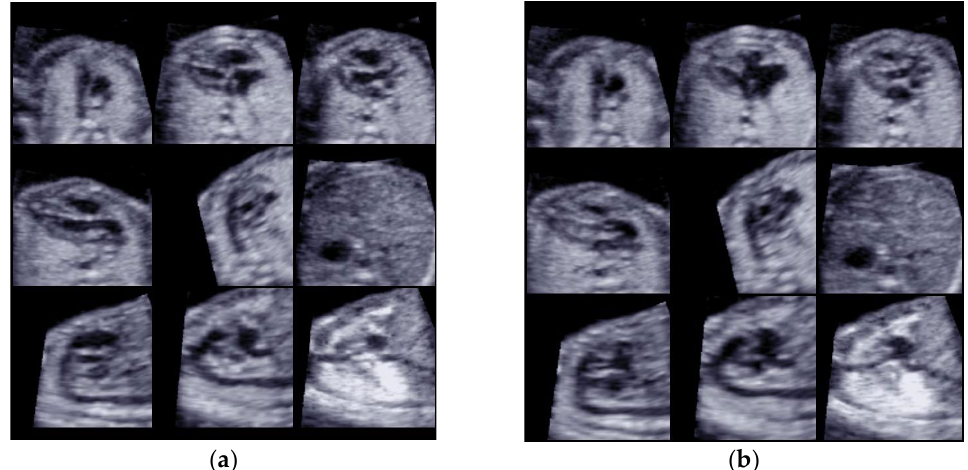
Figure 1. ( a ) Diagnostic planes with FINE in the systolic cardiac phase; 9 planes were used for the analysis. ( b ) Diagnostic planes with FINE in the diastolic cardiac phase; 9 planes were used for the analysis.